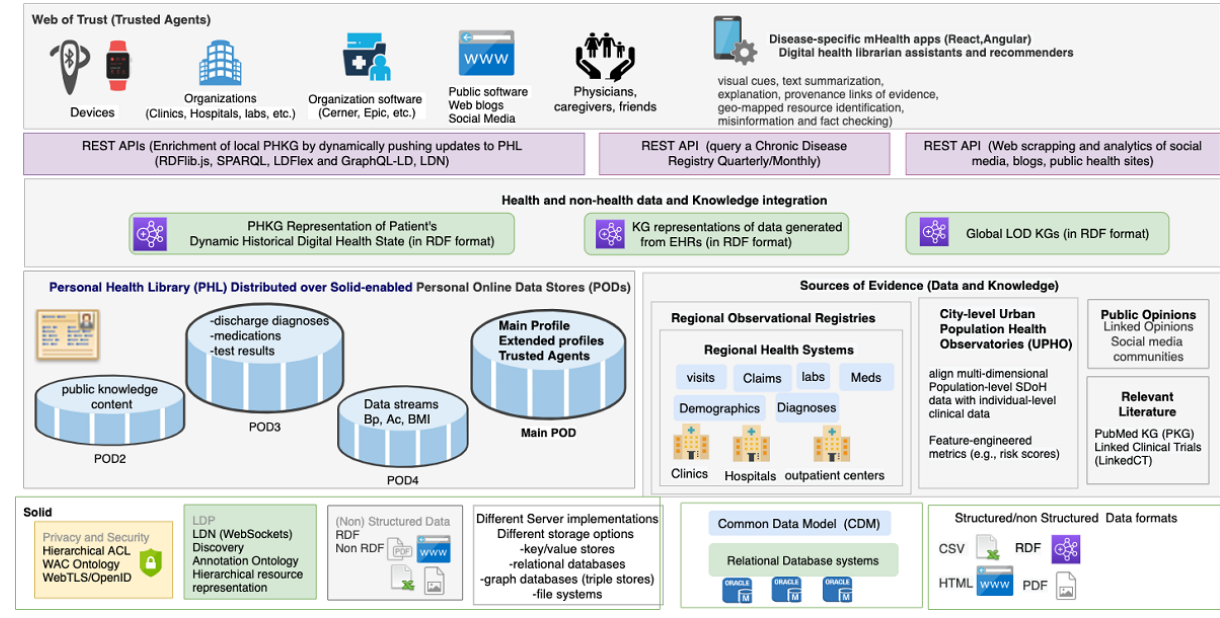
Figure 1. A PHL that leverages the semantic technologies and decentralized privacy and security mechanisms of Social Linked Data (Solid) to enable true ownership, data integration, interoperability, portability, and dynamic knowledge discovery. The PHL enables building Hybrid mHealth Recommenders and Digital Librarians (HRDLs). ACL: access control list; API: application programming interface; Bp: blood pressure; DWPC: Diabetes Wellness and Prevention Coalition; ED: emergency department; LDN: Linked Data Notifications; LDP: Linked Data Platform; LOD: Linked Open Data; mHealth: mobile health; OWL: Web Ontology Language; PKG: personal knowledge graph; RDF: Resource Description Framework; REST: